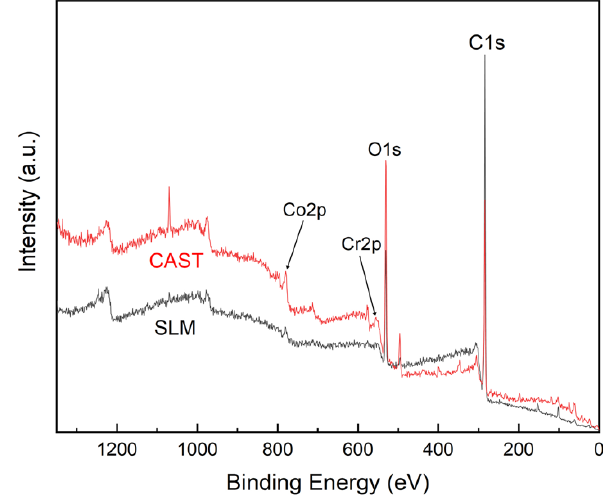
Figure 3. XPS spectra of the Co-Cr alloys.